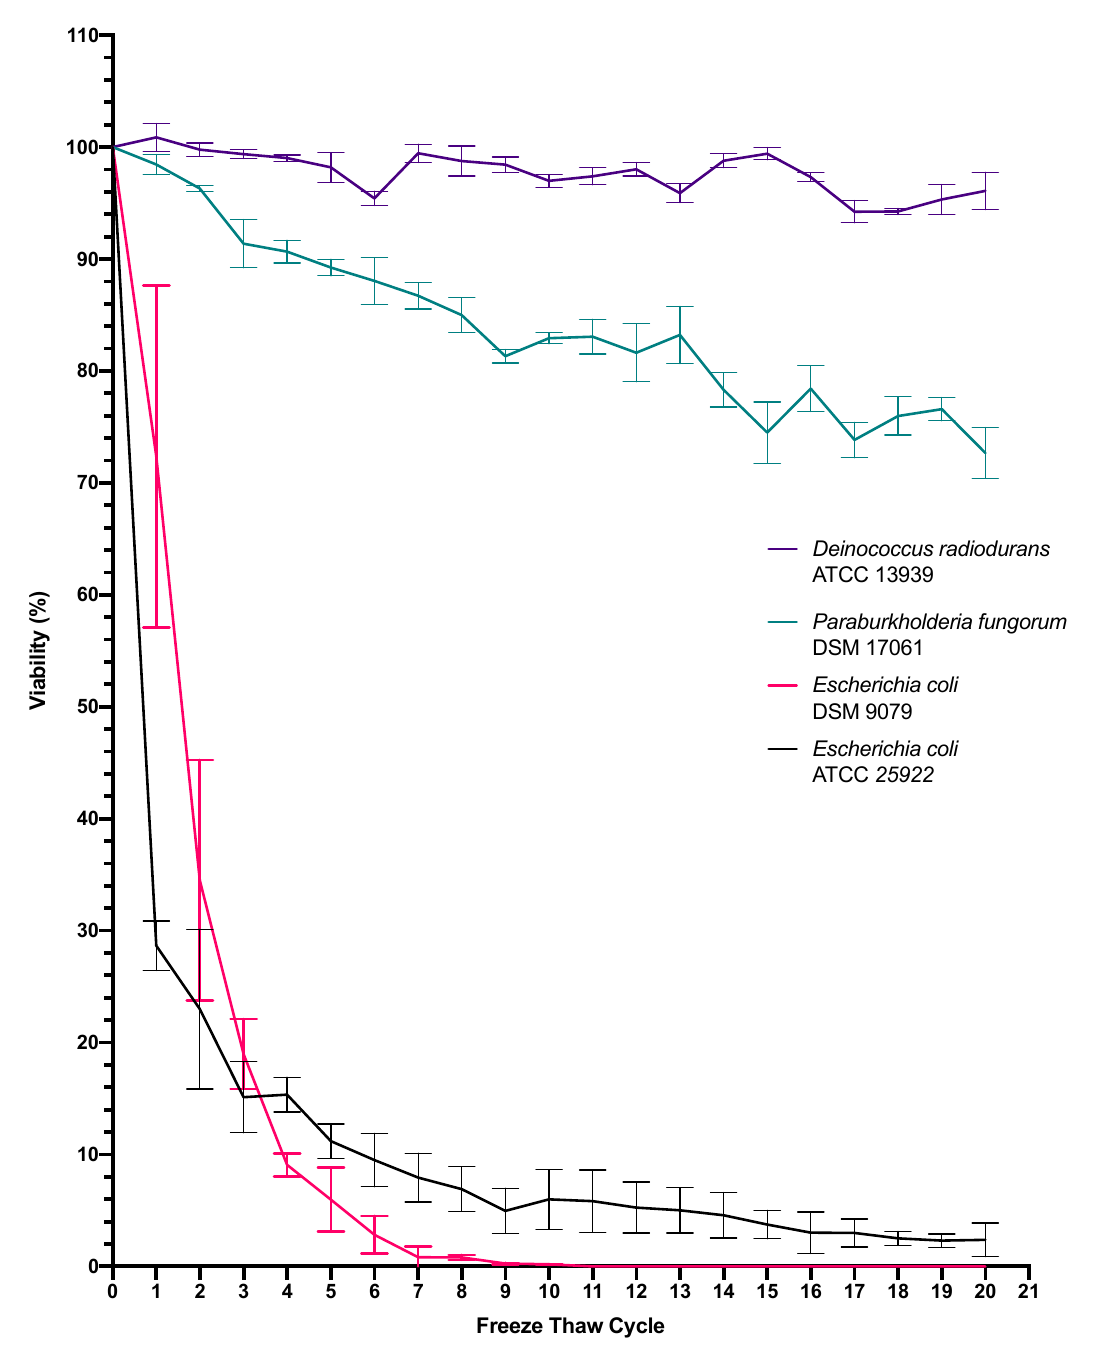
Figure 2. Percentage viability of E. coli ATCC 25922, E. coli DSM 9079, P. fungorum DSM 17061, D. radiodurans ATCC 1393 following successive freeze-thaw cycles ( − 80 °C to 30 °C). Note: Error bars depict +/ − one standard deviation about the mean for each test sample.